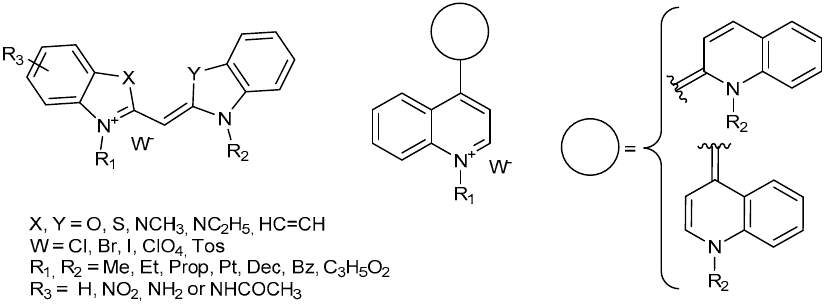
Figure 1. General structure of representative cyanine dyes under Figure 28. General structure of representative cyanine dyes under study.